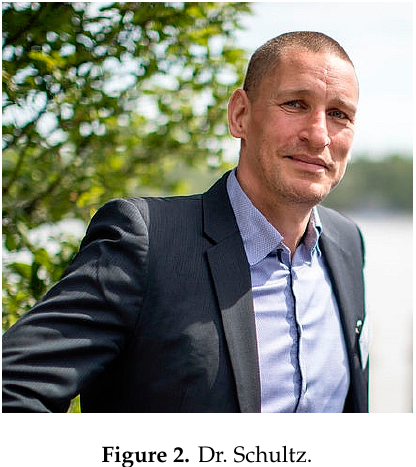
Figure 2. Dr. Figure 2. Dr. Schultz.